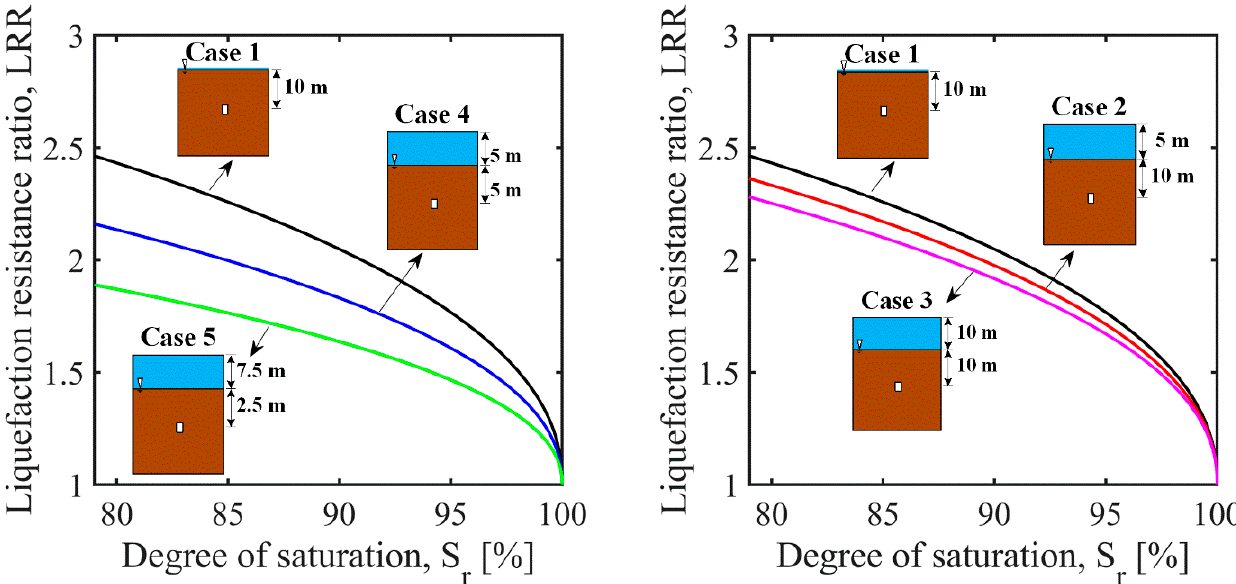
Figure 15. Variation in liquefaction-resistance ratio with the degree of saturation under different field conditions.